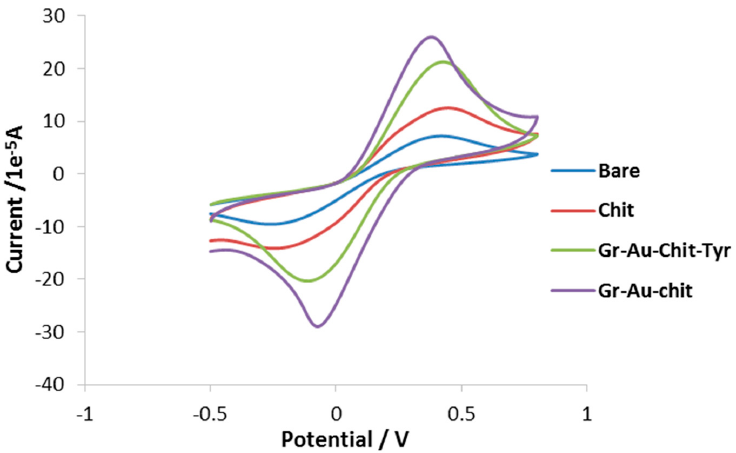
Figure 3. Cyclic voltammograms of the different modified SPCE in 5.0 mM K 3 Fe(CN) 6 /0.1 M KCl in the potential range of − 0.5 to − 0.8 V at scan rate 100